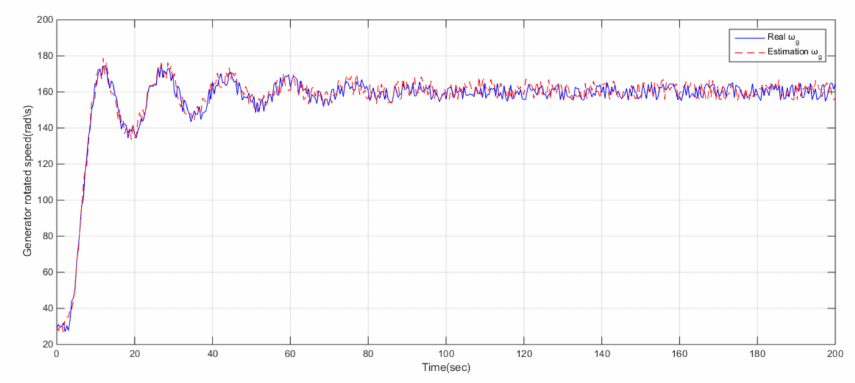
Figure 8. ω g with a fault present and its estimation.